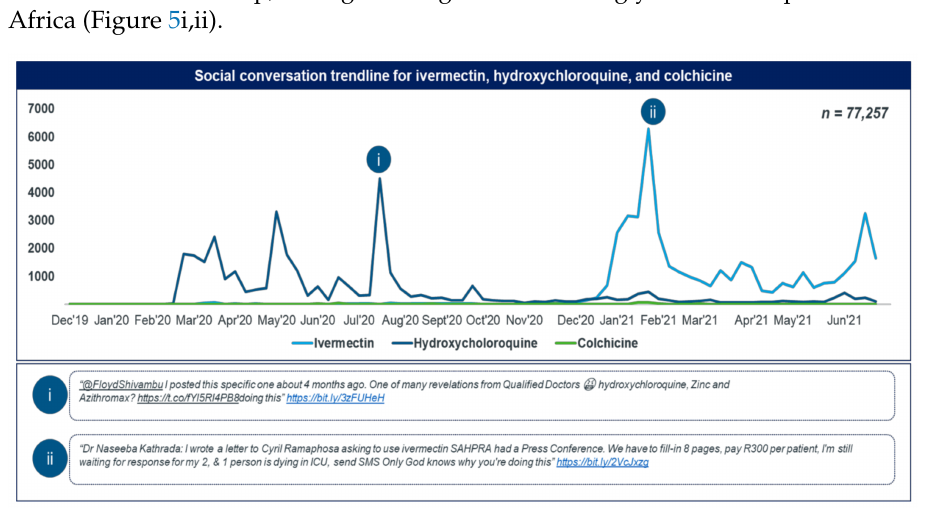
Figure 5. Combined social conversation trendline for ivermectin, HCQ, and colchicine.